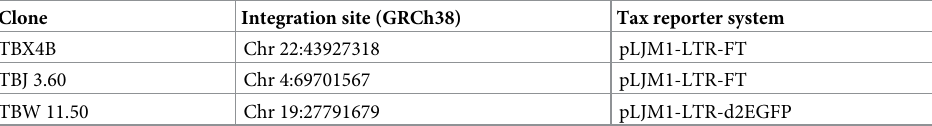
Table 1. Patient-derived T-cell clones expressing fluorescent protein-based Tax reporter